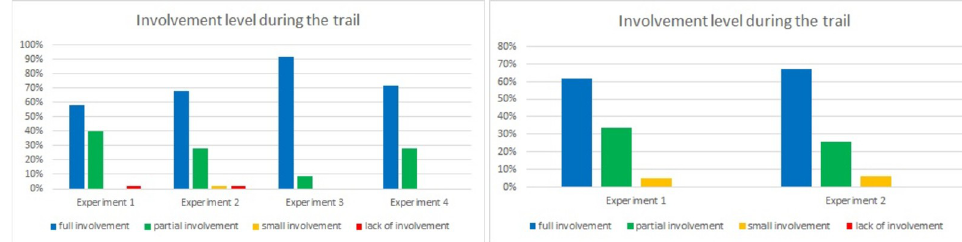
Fig 17. Evacuees’ involvement level during consecutive experiments—question 8. (Results from the Laliki experiment are on the left; results from Gda ń sk are on the right).